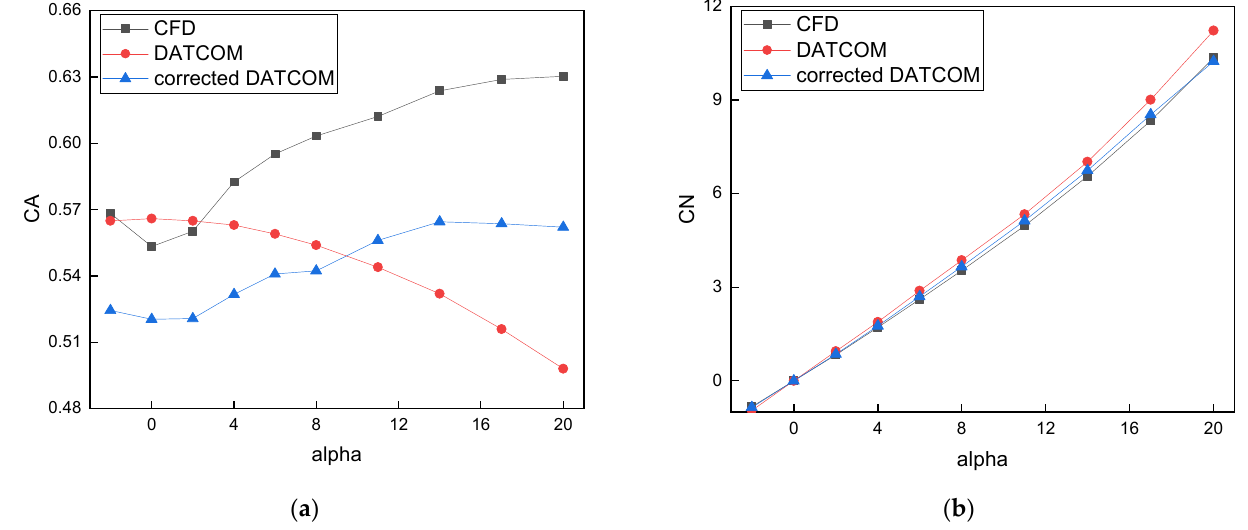
Figure 10. Aerodynamic coefficient at Ma = 2.1. ( a ) CA and ( b ) CN.